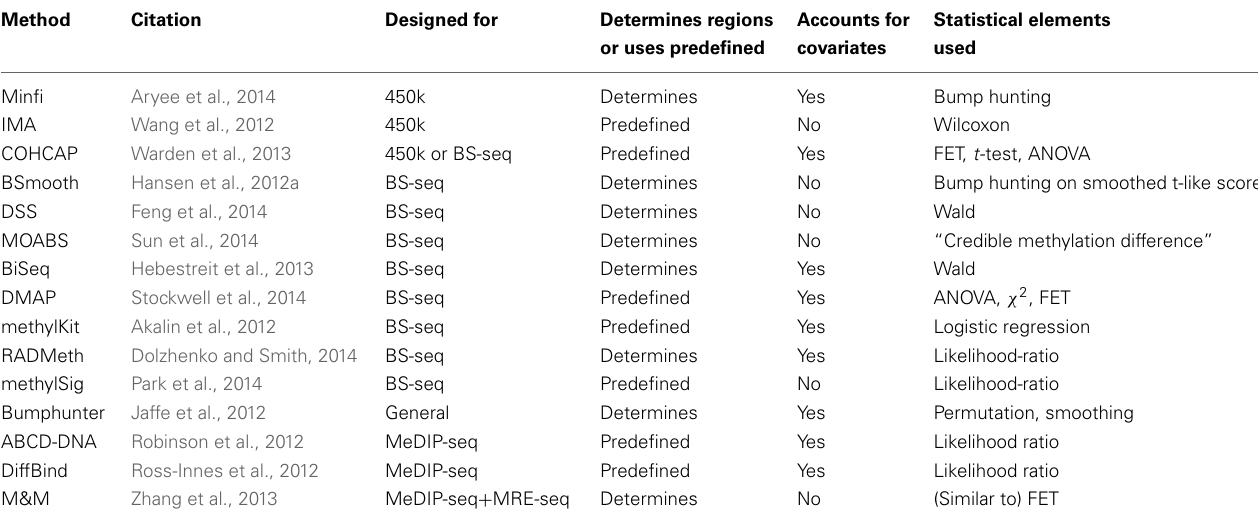
Table 2 | List of recent methods to detect differentially methylated loci or regions.